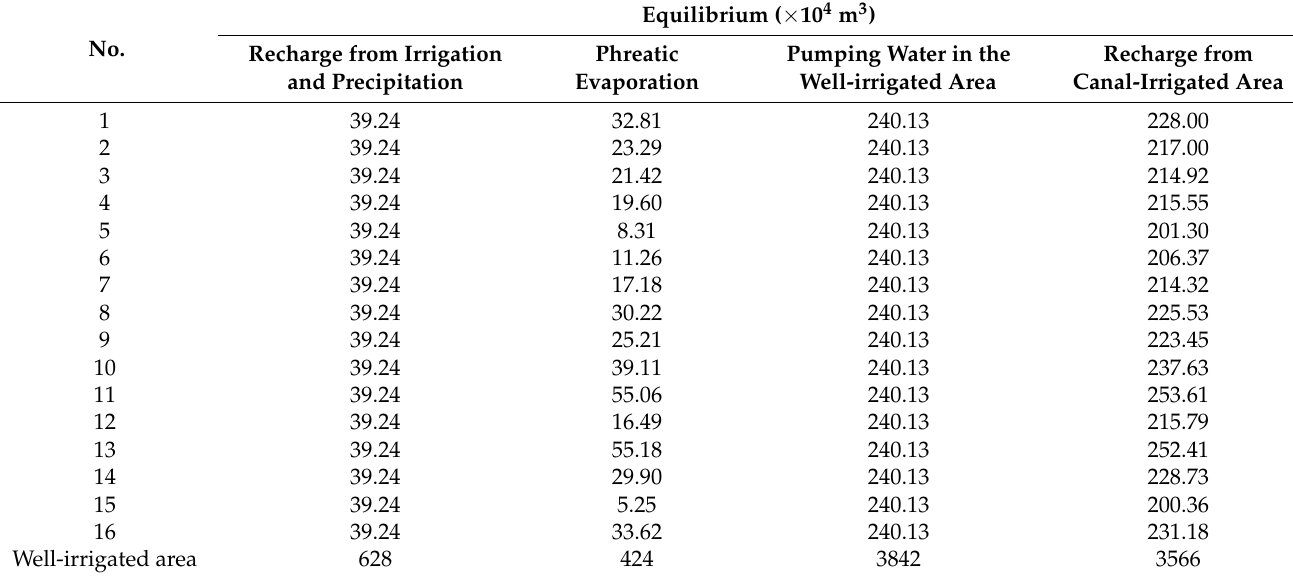
Table 7. Annual average water balance of different areas after well-canal conjunctive irrigation.